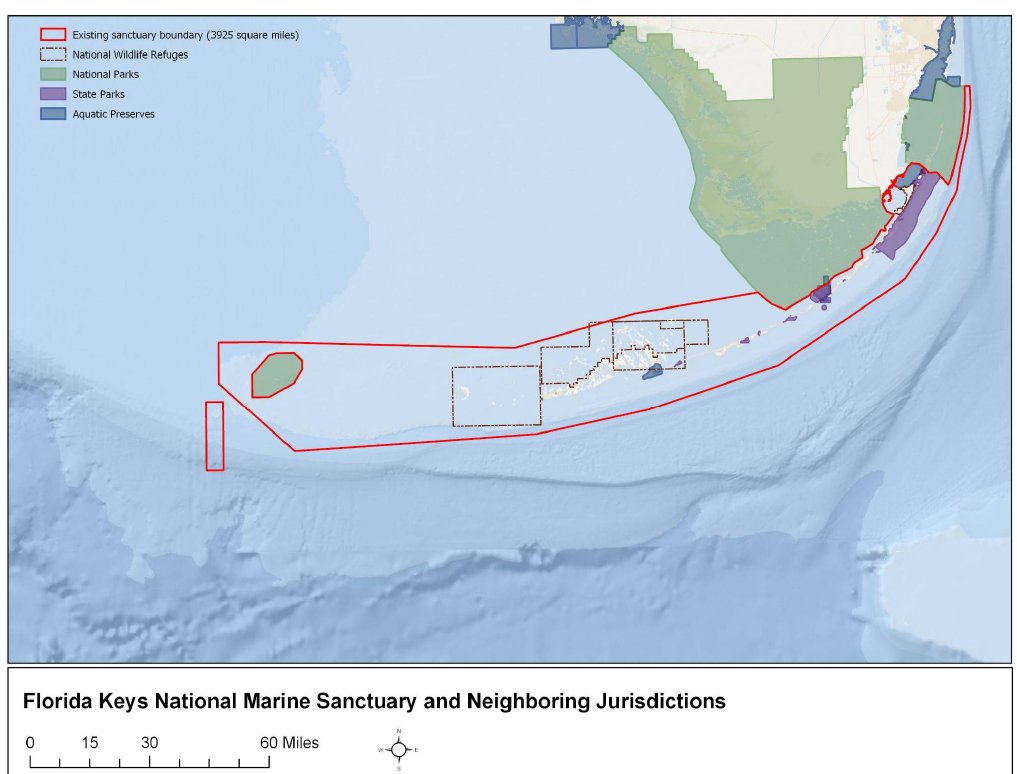
Figure 1. Overview of the FKNMS boundary and neighborhood conservation jurisdictions.